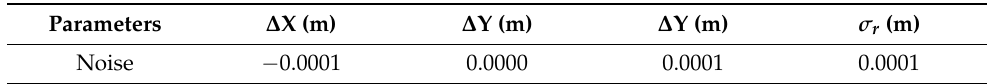
Table 2. Baseline components from the zero baseline